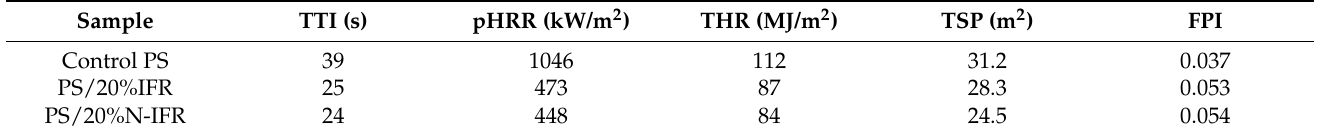
Table 3. The cone calorimeter tests results of control PS and PS composites.